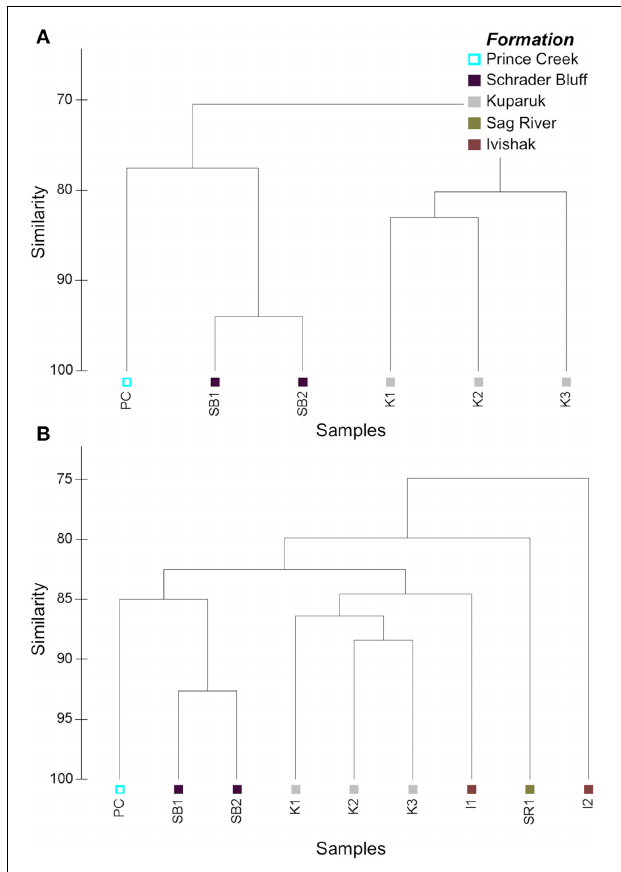
FIGURE 4 | Cluster plots based on Bray-Curtis similarities of PhyloChip hybridization intensity data used to compare (A) archaeal and (B) bacterial microbial community structures. Hybridization scores were post-scale-normalized to total array intensity.